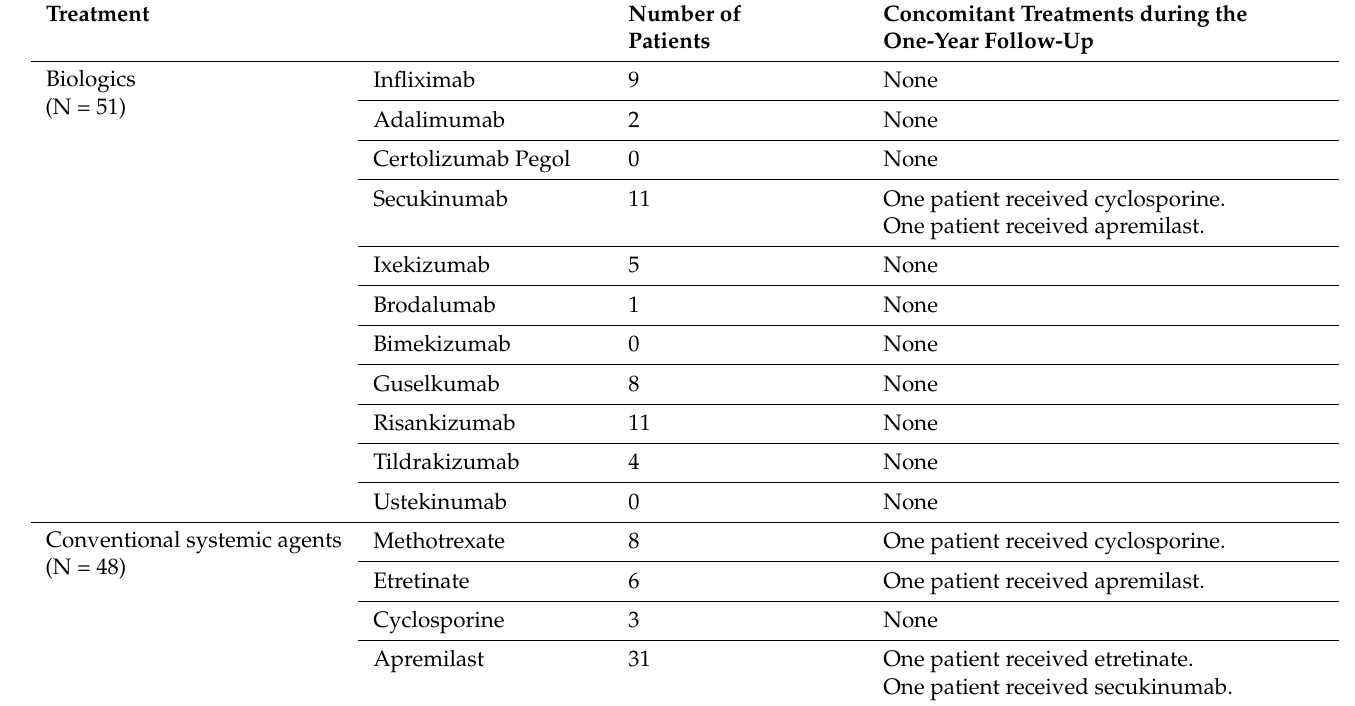
Table 5. The number of patients initiating each systemic therapy and concomitant treatments during the one-year